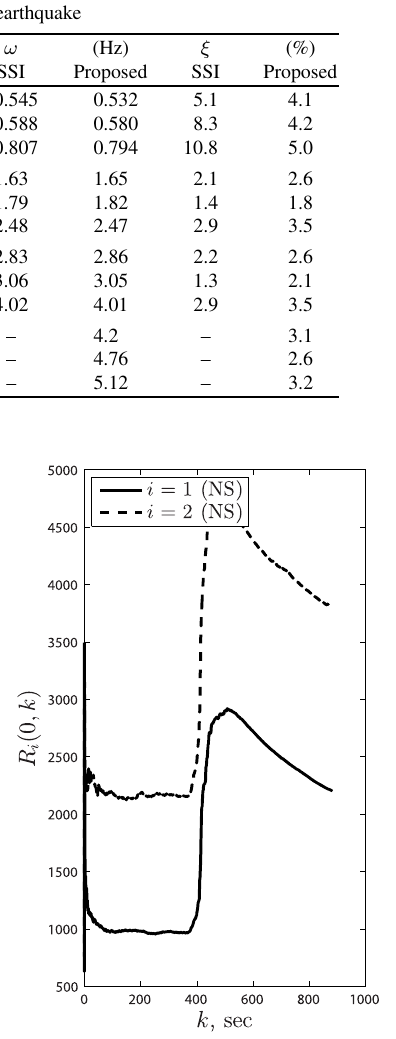
Table 3 Undamaged state: Identified ω and ξ of the UCLAFB before the